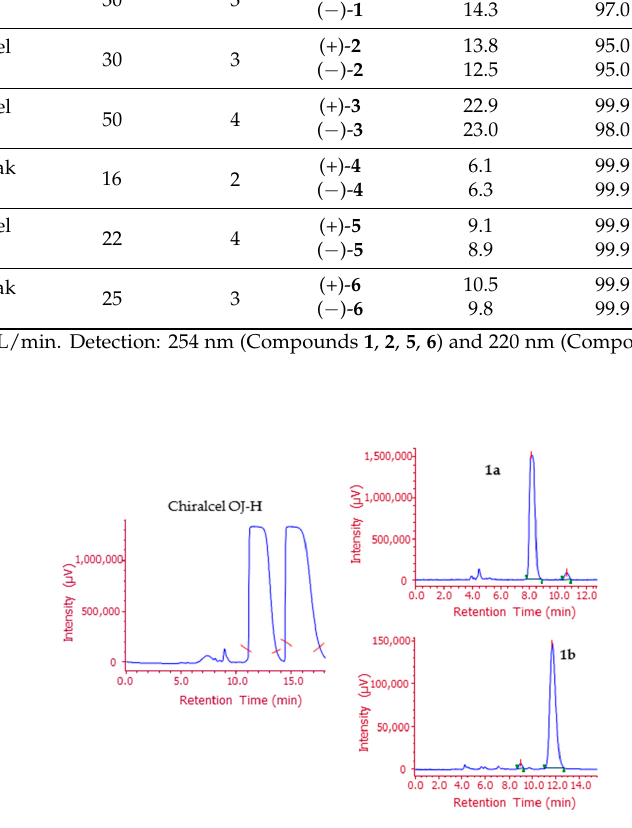
Figure 3. Representative chromatogram of (semi-)preparative resolution: compound ( R / S )- 1, Chiralcel OJ-H (10 mm × 250 mm, dp = 5 μ m). Elution condition: 100% EtOH, DEA 0.1%, flow rate 2.5 mL/min. Injection volume 1.0 mL. 1a : (+)- 1 , 1b : ( − )- 1